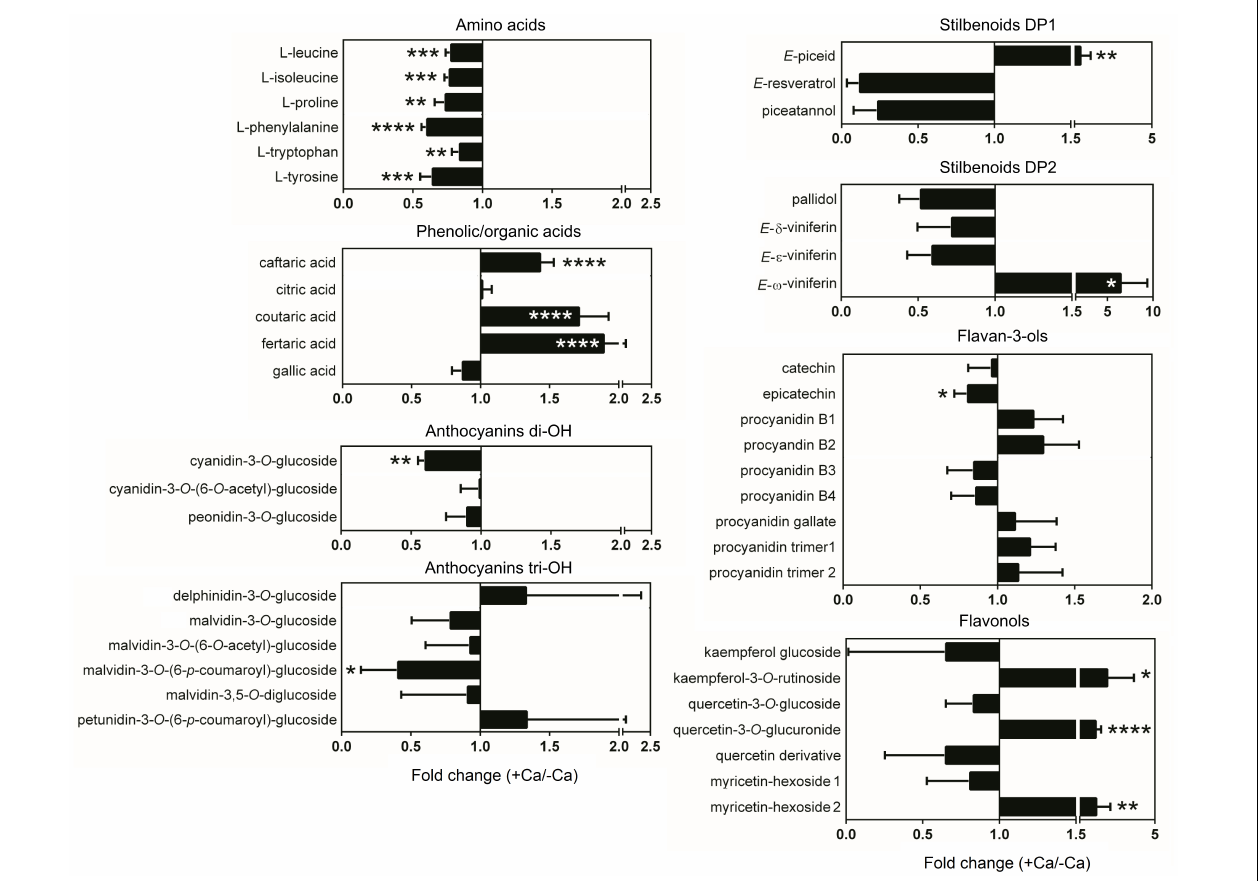
FIGURE 4 | Effect of Ca on the metabolite profile of grape berries cv. Loureiro. Results are expressed as fold changes of the mean ± SD values obtained for Ca treatment (+ Ca) relative to the control (– Ca), and asterisks indicate statistical significance of + Ca vs. – Ca for each metabolite: * P ≤ 0.05; ** P ≤ 0.01; *** P ≤ 0.001; **** P ≤ 0.0001; n =